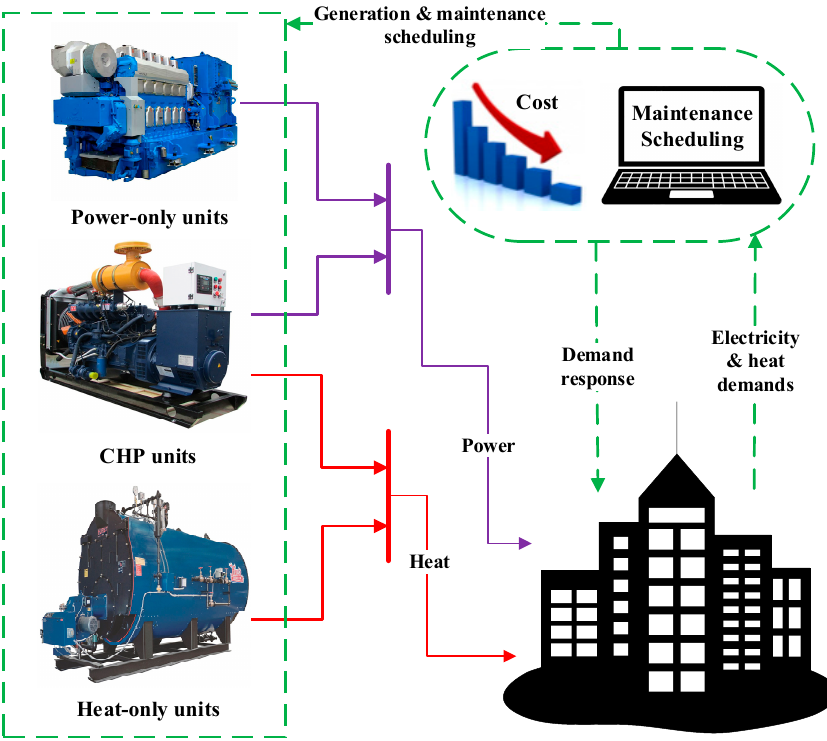
Figure 1. Diagram of the system under study.